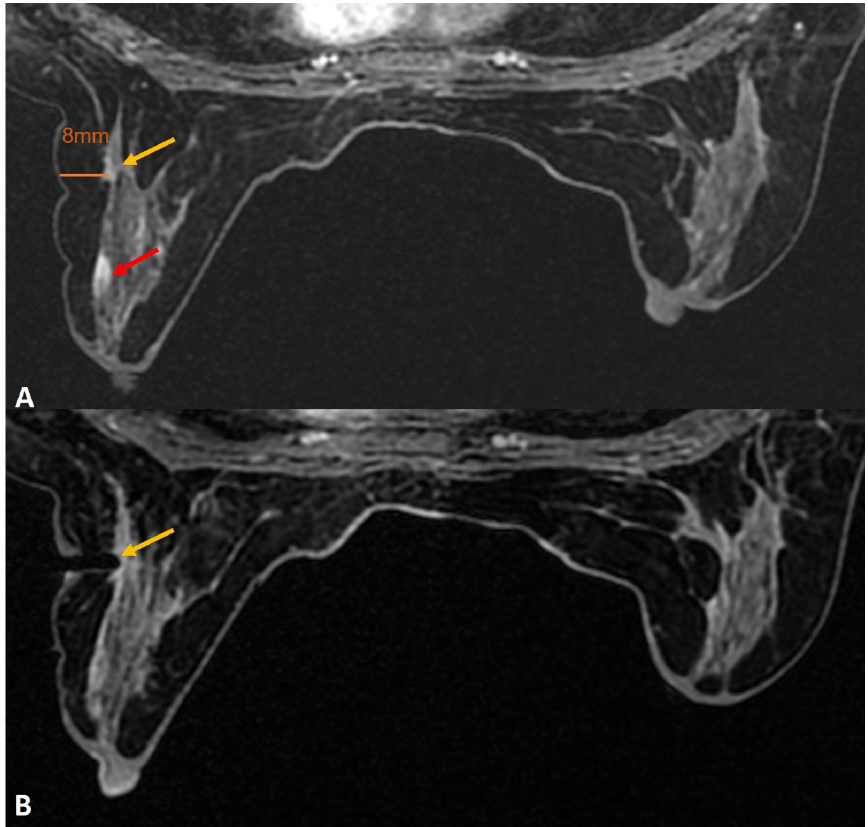
Figure 6. ( A ). Known right breast DCIS in anterior third depth (red arrow). Small indeterminate enhancing mass in the posterior breast (yellow arrow) was for biopsy to assess the extent of DCIS to plan the surgery. The target was seen 8 mm from the skin, as shown. The tip of the obturator is seen at the target. A normal 20-mm aperture needle would leave part of the trough outside the skin and can lead to injury to skin and air leak during biopsy. ( B ). A small-aperture, blunt tip Petit needle (12 mm aperture) (yellow arrow) was used for safety and reducing the risk of skin laceration. (b) Small-sized lesions obscured by grid (Figure 7): Occasionally, a small lesion to be biopsied may fall on a “ cross ” of the grid during the biopsy. In this case, the grid obscures the ideal entry site and offsets the needle. Hence, using two diagonally placed entry sites from the adjacent holes, along with directed sampling, may further enhance the chance of success. Targeted sampling with extra cores directed towards the lesion may help in this situation. (c) Lesion Movement (Figure 8): Lesion movement may be due to patient movement, inadequate breast compression, or skin indentation. Firstly, the patient must be comfort- able and well-informed of the procedure to avoid startling her. If needed, readjust the patient’s position. Adequate breast compression is needed to immobilize the breast well, and a good skin incision may avoid excessive skin indentation. Occasionally, inserting the needle beyond the target and then withdrawing it to the correct depth may help to get a perfect location of the needle aperture at the targeted site.